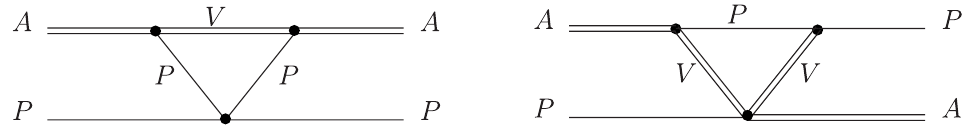
Figure 2. Possible triangle diagram contributions to the scattering between an axial vector meson and a pseudoscalar